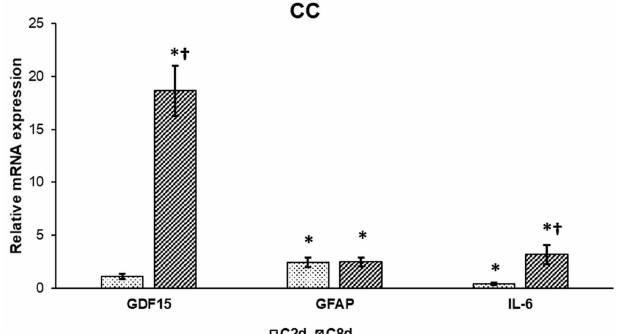
Figure 1. Relative mRNA expressions of GDF15, GFAP, and IL-6 in cuprizone (CZ) treated groups. Real Time PCR was performed with SYBR green protocol using gene specific primers. β -actin was used as housekeeping gene for the normalization and relative expression of control was considered as 1. The bars represent mean values and error bars represent standard errors of the mean (SEM) for three independent determinations. Student’s t -test was used to determine the statistical significances between the control and the treated groups. To determine the statistical significance between the treated groups a two-sample t -test was used. The asterisk shows p < 0.05 compared to the controls, the cross indicates di ff erence p < 0.05 between the treated groups, n = 6 in each